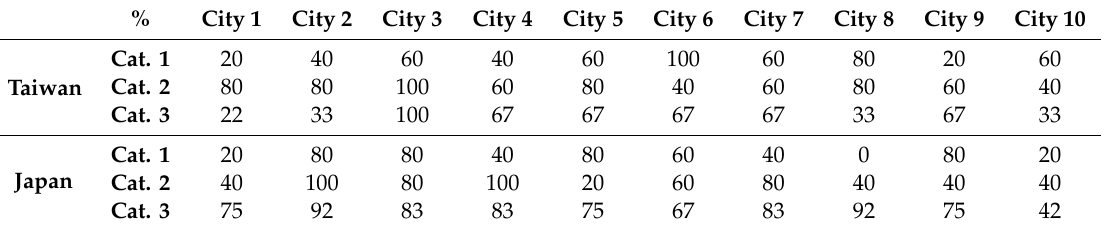
Table 13. Percentage of respondents who want to visit the less-known tourist attractions.